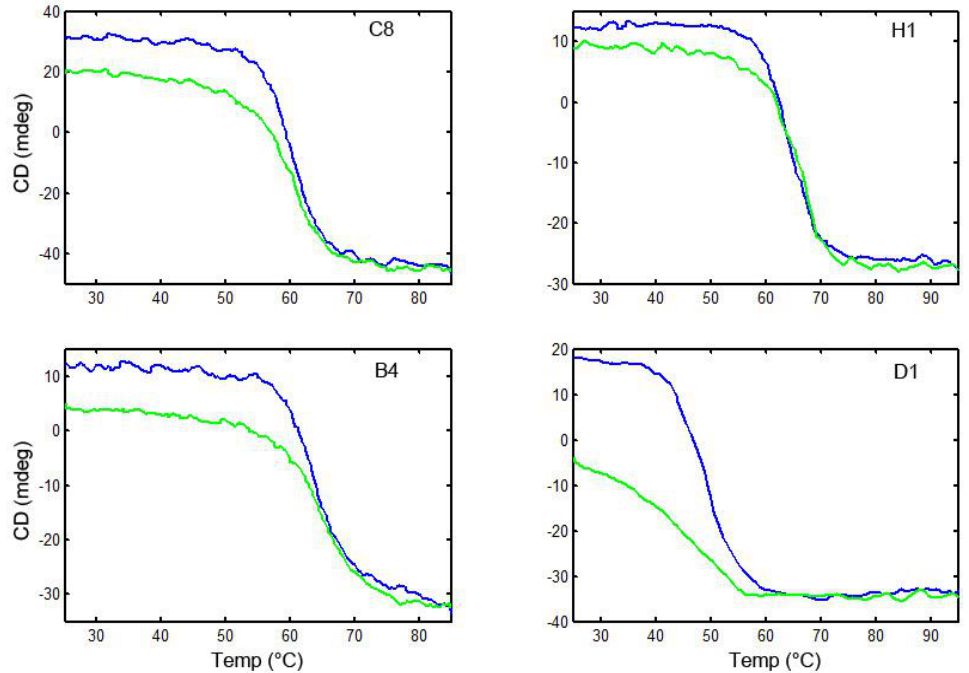
Figure 4. Circular dichroism of parental sdAb. Following the elipticity of the sdAb on heating and then cooling, the melting and subsequent refolding of these sdAb can be monitored. Blue curve is heating, and green is